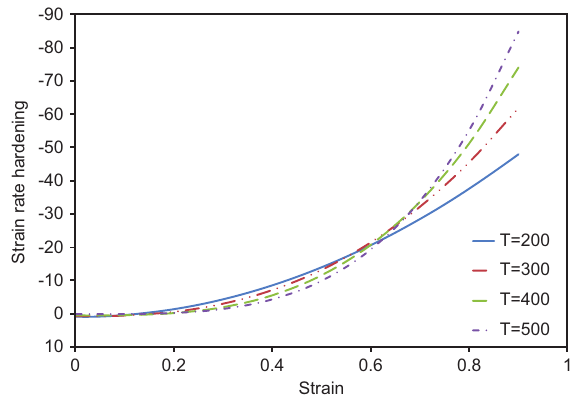
Figure 14 Change of strain hardening vs. strain of CR-1018 steel for different